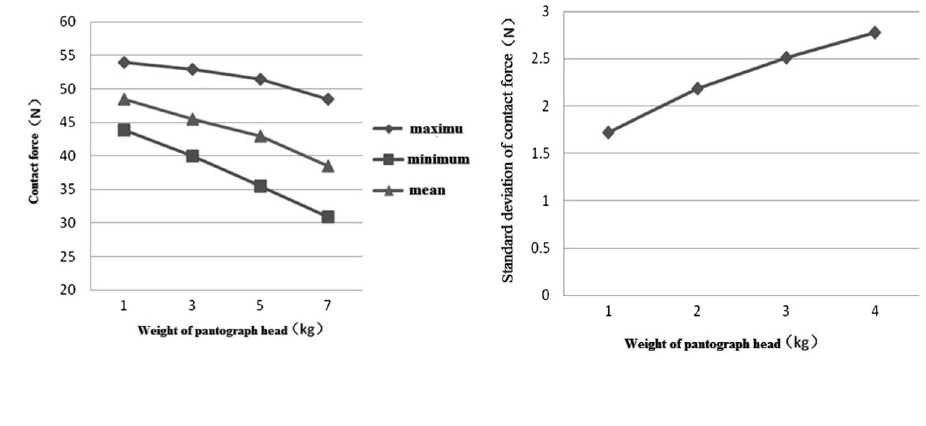
stiffness of left pantograph head elastic element on power collection quality in curved track